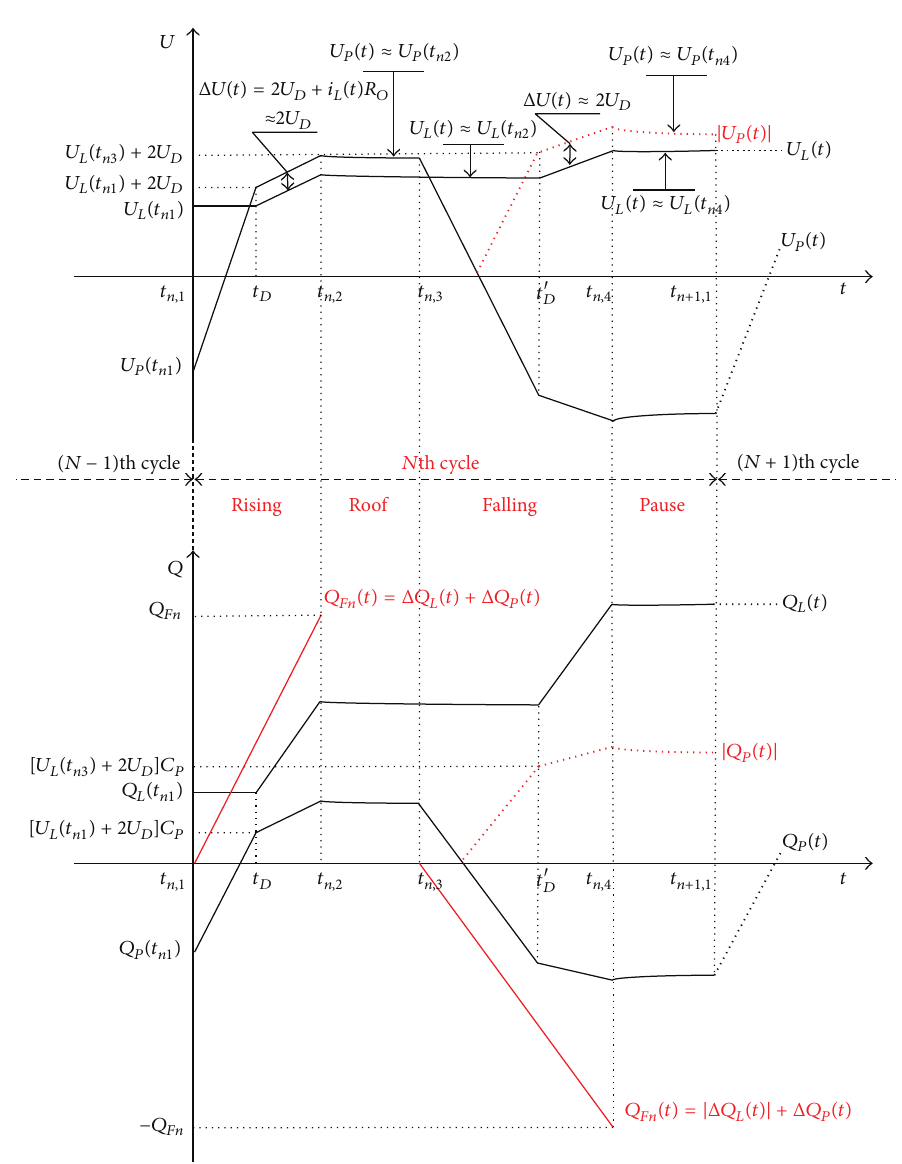
Figure 8: The charging process of 𝐶 𝐿 during one